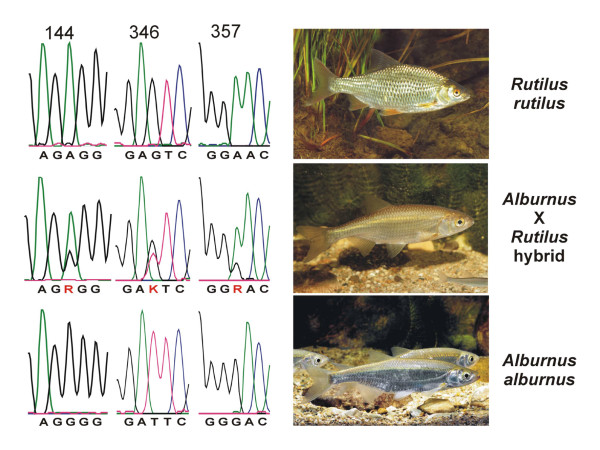
Hybrid status analysis in a natural case. Samples were obtained from pure species of R. rutilus and A. alburnus, as well as from a suspected hybrid animal. The sequence traces show diagnostic positions for the two species and confirm double peaks at the respective positions for the apparent hybrid animal.